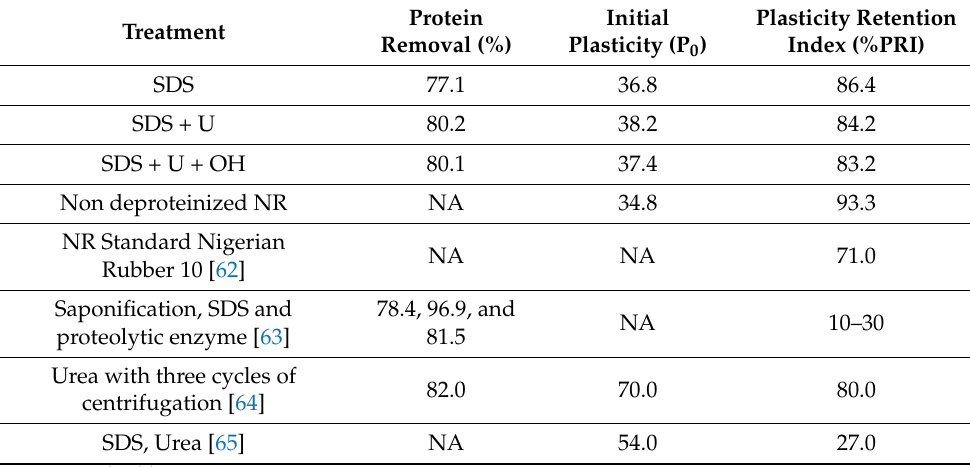
Table 4. Initial plasticity and plasticity retention index of DPNR Colombian from Hevea brasiliensis .